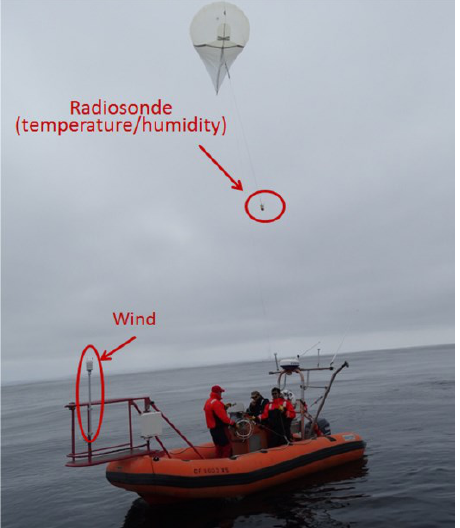
Figure 1. RHIB-based surface layer profiling measurements offshore in Monterey Bay on 2 May 2015. The sensors and the corresponding measured variables are indicated in the image.